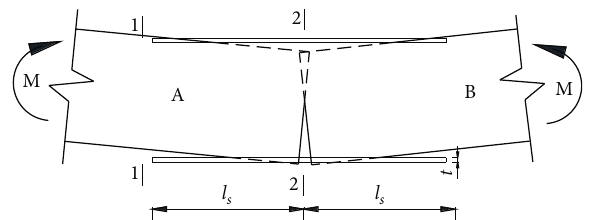
Figure 19: Deformation of steel plate hoop